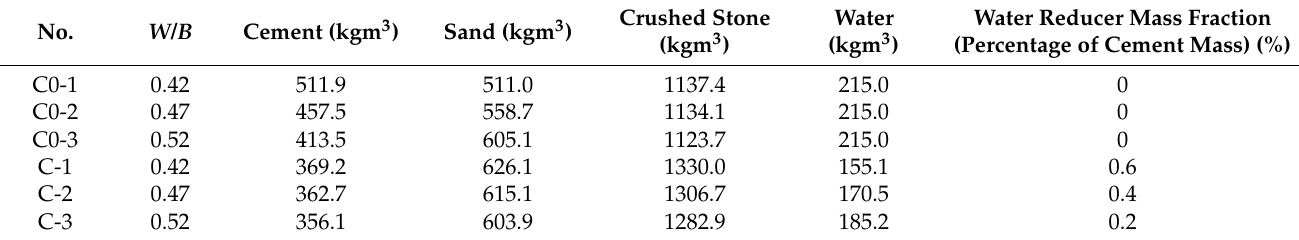
Table 7. Concrete mix ratio.